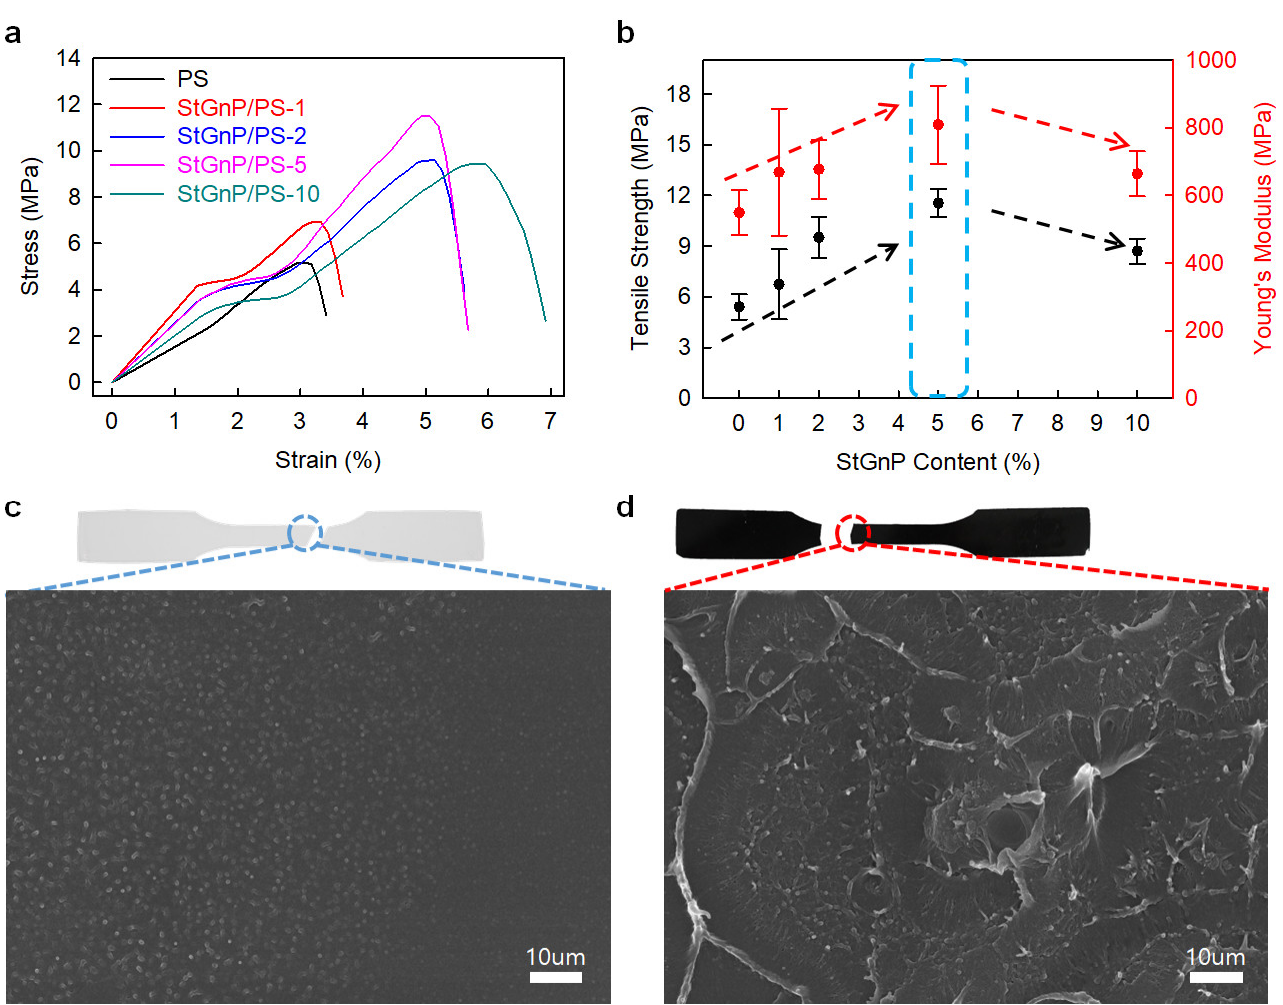
Figure 7. ( a ) S–S curves of pure PS and StGnP/PS nanocomposites. ( b ) Tensile strength and Young’s modulus of pure PS and StGnP/PS nanocomposites. SEM images of the fractured surfaces after the tensile test: ( c ) pure PS and ( d ) StGnP/PS-5 nanocomposite. Reprinted with permission from Ref. [41]. Copyright 2021 Kang and Kim .